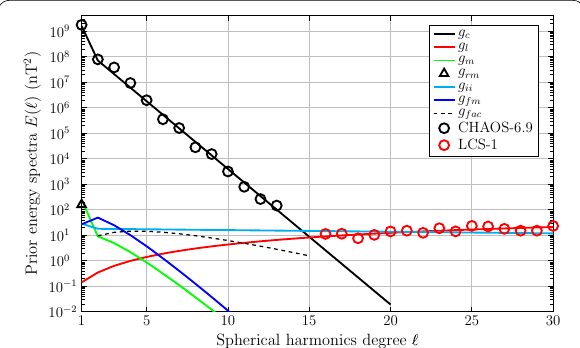
Fig. 1 Stationary state energy spectra at the Earth’s surface of the different magnetic sources given in Table 1. Black and red circles are the energy spectra of, respectively, the CHAOS-6.9 core field model of Finlay et al. (2016) in 2015.0 and the LCS-1 lithospheric field model of Olsen et al.